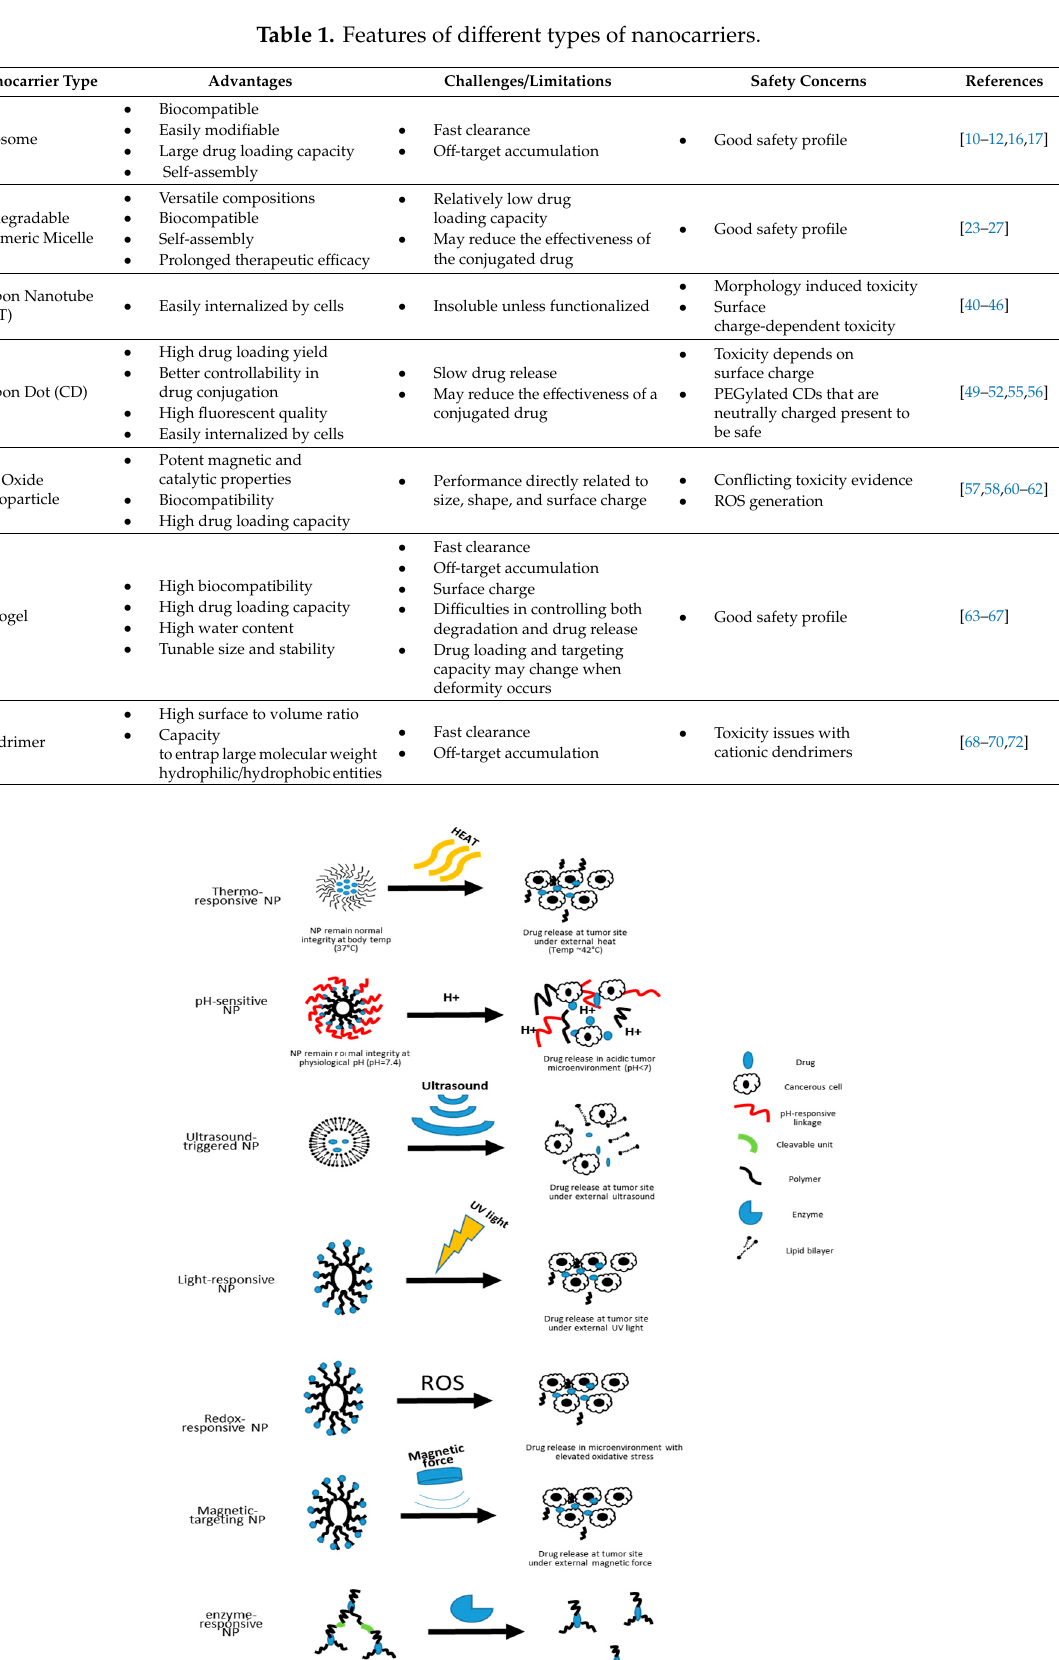
Figure 2. Schematic illustration of the drug-releasing mechanisms of different types of nanocarriers.